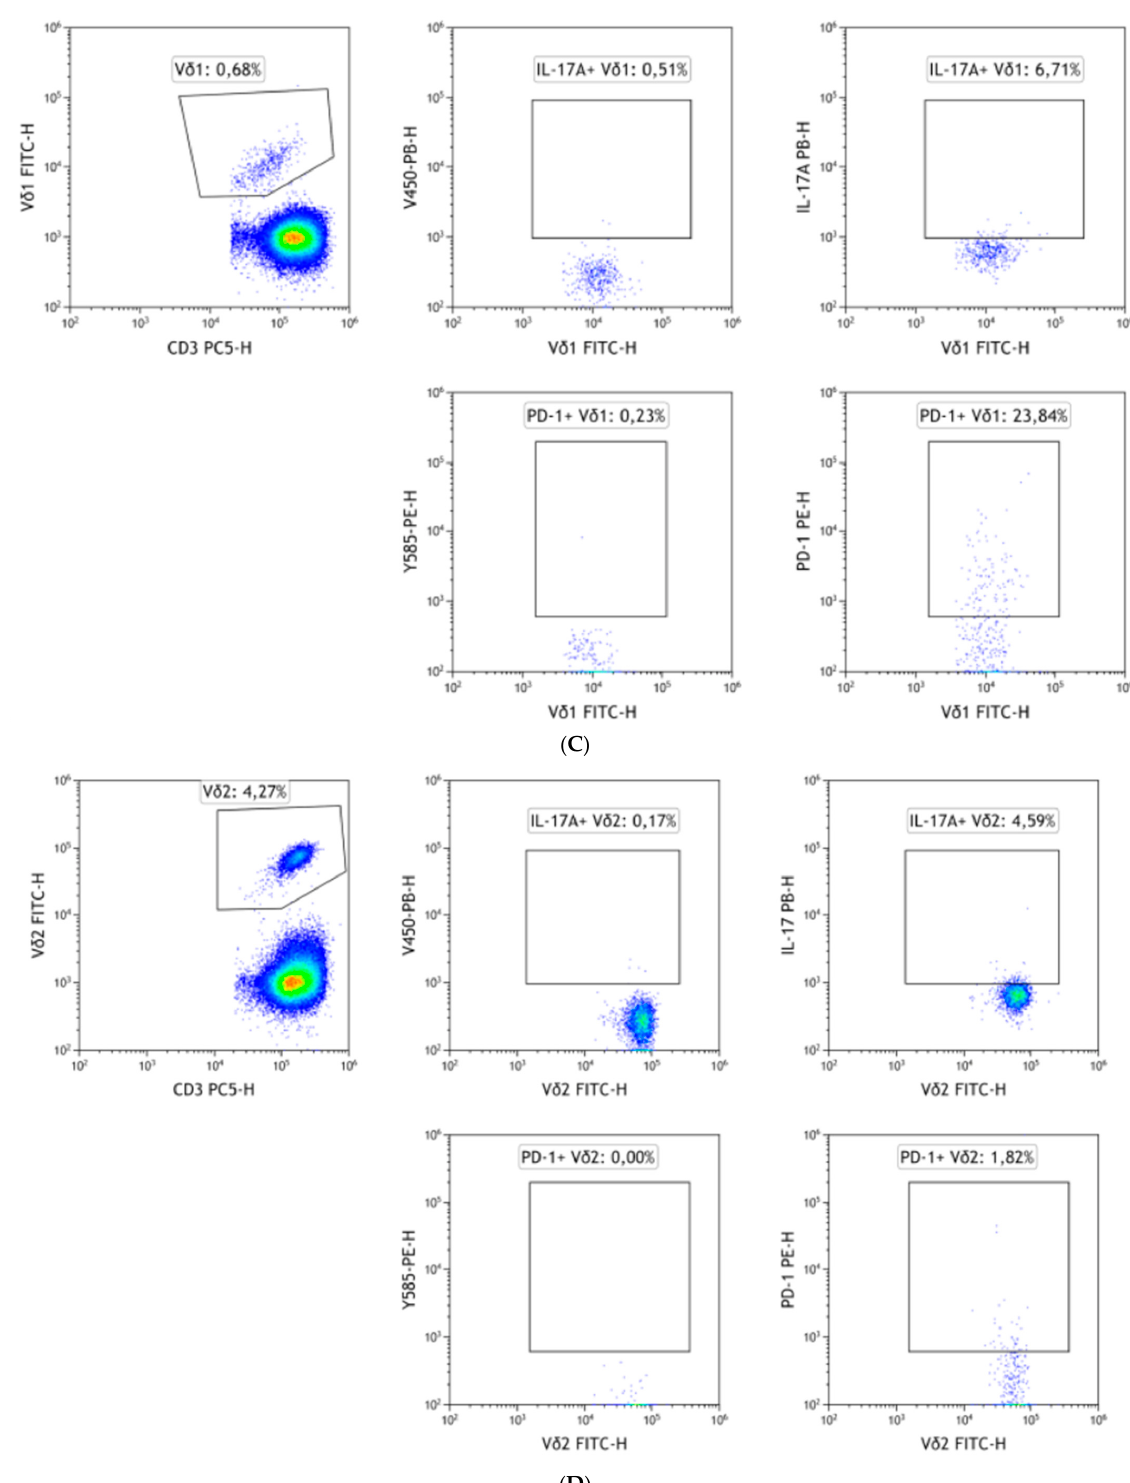
Figure 1. Gating strategy. Initially, singlets were gated based on FSC-H/FSC-A. Next, a lymphocyte gate was applied on SSC-A/FSC-A. Finally, T lymphocytes were gated as CD3+ cells ( A ). Then, γδ T, V δ 1 or V δ 2 cells were gated among CD3+ cells. Expression of IL-17A and PD-1 was assessed as a percentage of positive cells, thus FMO ( left ) controls were used for gating ( B – D ). PECAM-1 and NKRP1A expression was quantified using MFI